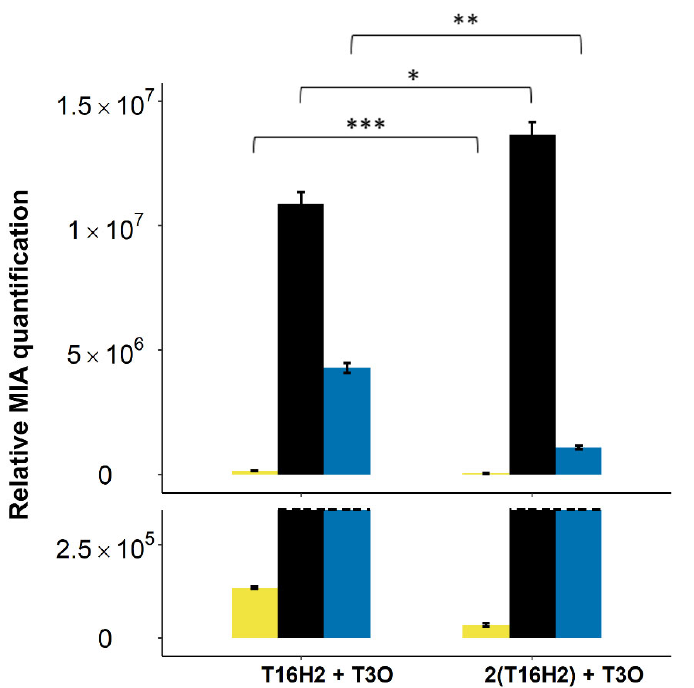
Figure 2. Evaluation of the competition between T16H2 and T3O for tabersonine in yeast. Alkaloids were quantified by UPLC ‐ MS in the yeast culture medium 24 h post ‐ feeding with tabersonine (250 μ M). The dashed line represents the scale cut for the visualization of accumulated intermediates of low volume. The yeast strain harbors episomal plasmids containing one or two copies of T16H2 and one copy of T3O. Light yellow = tabersonine, black = 16 ‐ hydroxytabersonine, blue = tabersonine epoxide. Statistical analyses were performed with a two ‐ tailed t ‐ test ( p ≤ 0.1, *: p ≤ 0.05, **: p ≤ 0.01, ***: p ≤ 0.001). MIA composition of the yeast culture medium is expressed as relative peak areas.